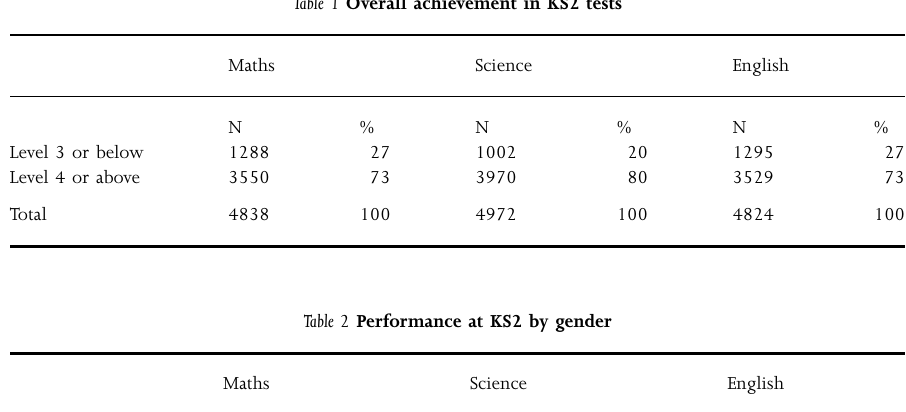
Table 1 Overall achievement in KS2 tests